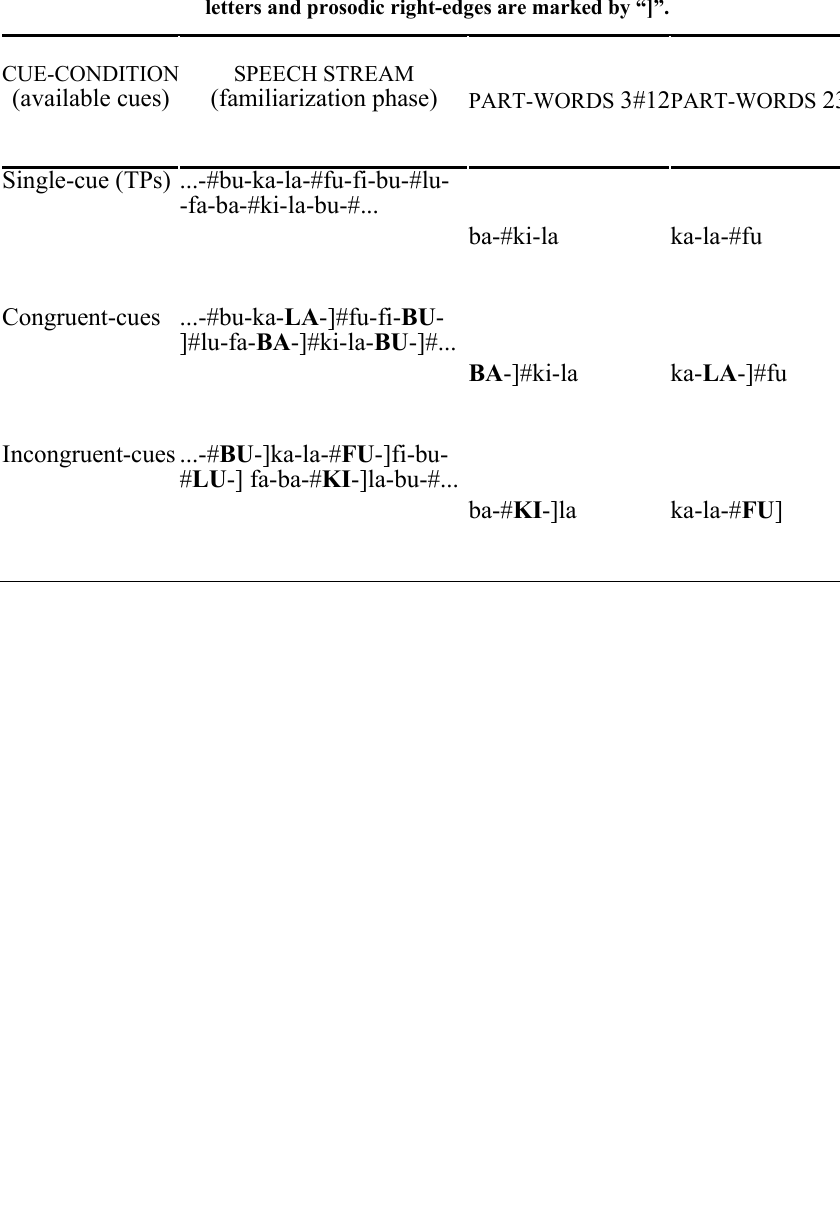
Table 1: Experiment 1: Orthographic translation of a sample of the stream heard in the familiarization phase in the four cue-conditions, and of the AL stimuli (TP-words; part-words 3#12 and part-words 23#1). The “#” defines word boundaries according to TPs, the “-” represents concatenation; the prosodic marked syllable is in bold capital letters and prosodic right-edges are marked by